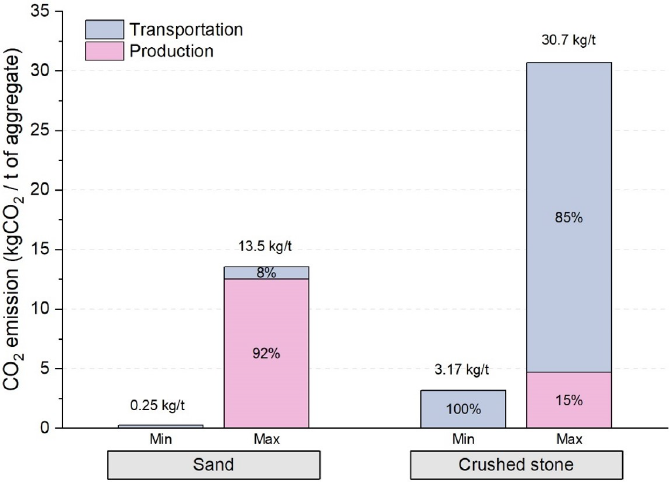
Figure 5. Minimum and maximum CO 2 emissions of aggregates.